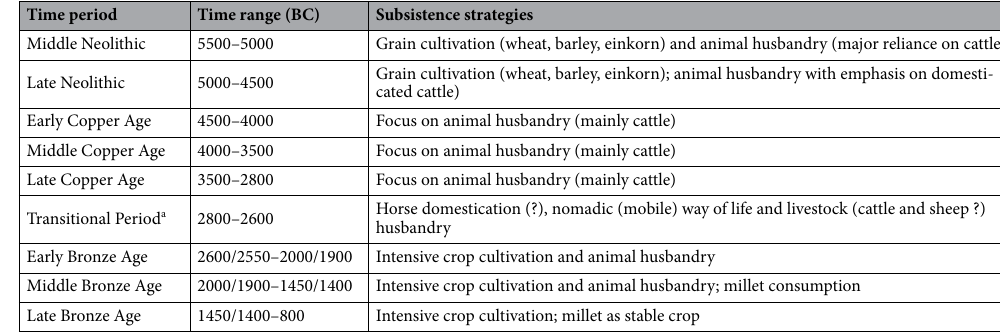
Table 1. Summary of the prehistoric time periods and their and subsistence practices in the Great Hungarian Plain. a Transition to the Bronze Age after the constant East European (Yamnaya) impact between 3100/3000 and 2800 BC (Refs. 26–32